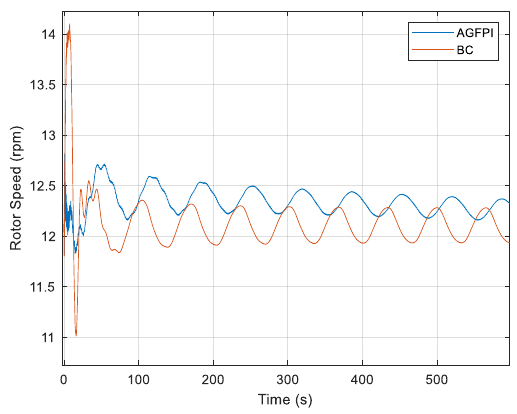
Figure 5. Rotor speed without waves.